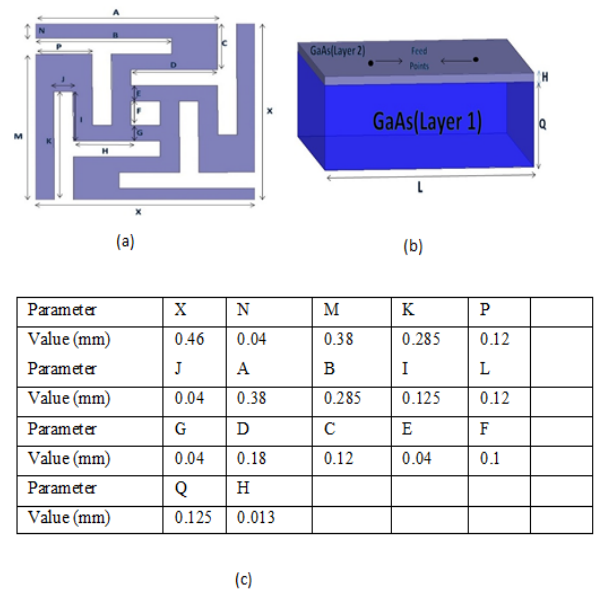
Figure 9: THz antenna design (a)Top view of patch antenna with T shape patches at the four corners (b) side view of patch antenna showing GaAs substrate (c) antenna dimensions The perturbation of electric and magnetic field inside the medium and their interaction causes higher order fields that result in the electromagnetic scattering of waves. Fig.